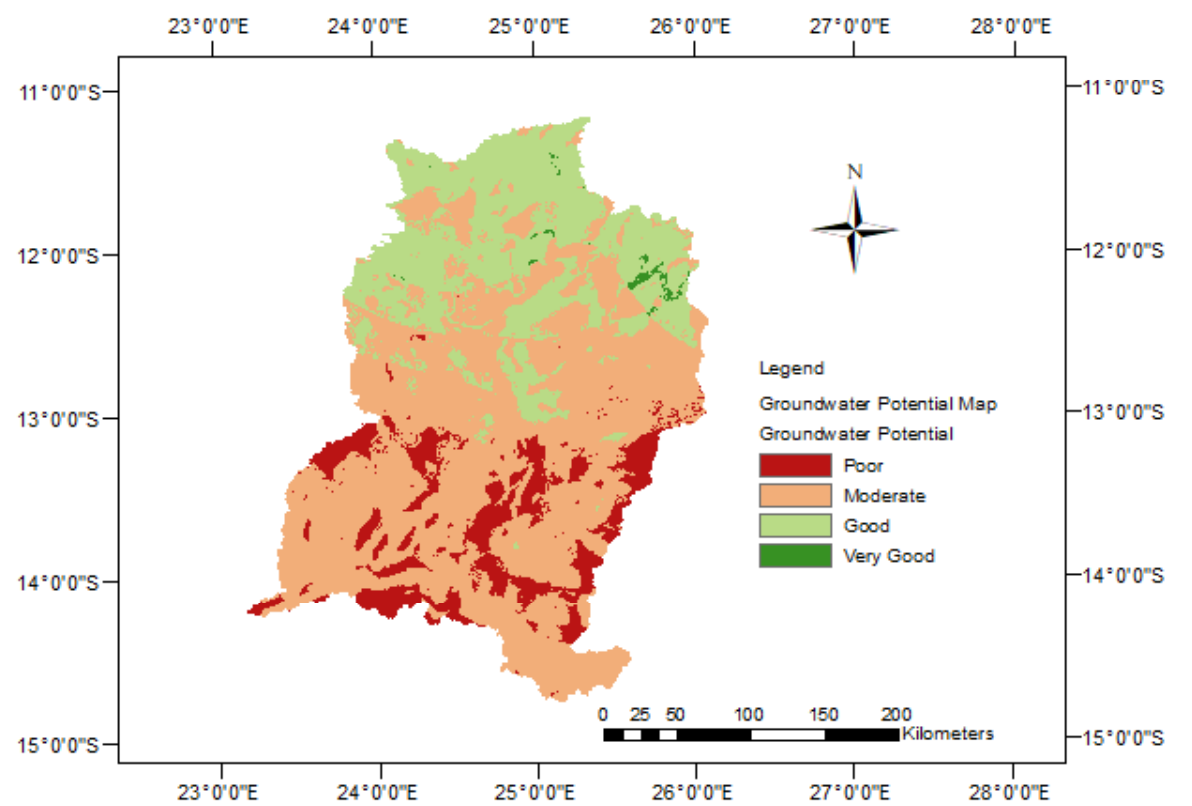
Figure 10. Ground Water Potential Map of the Kabompo catchment.